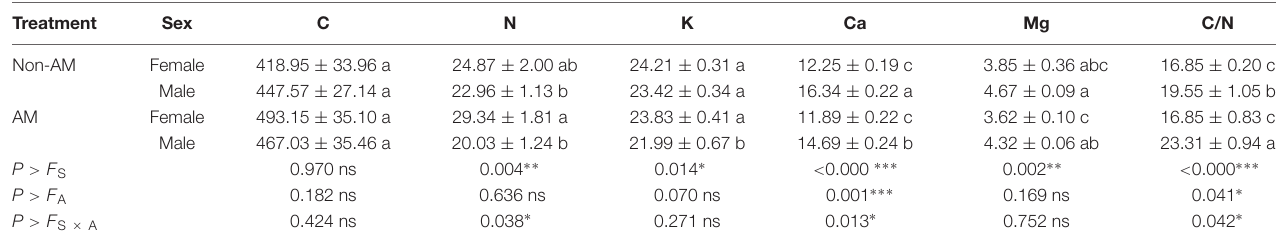
TABLE 3 | The C, N, K, Ca, and Mg content and C/N ratio in leaves of female and male Populus cathayana saplings as affected by arbuscular mycorrhizal (AM) fungi.